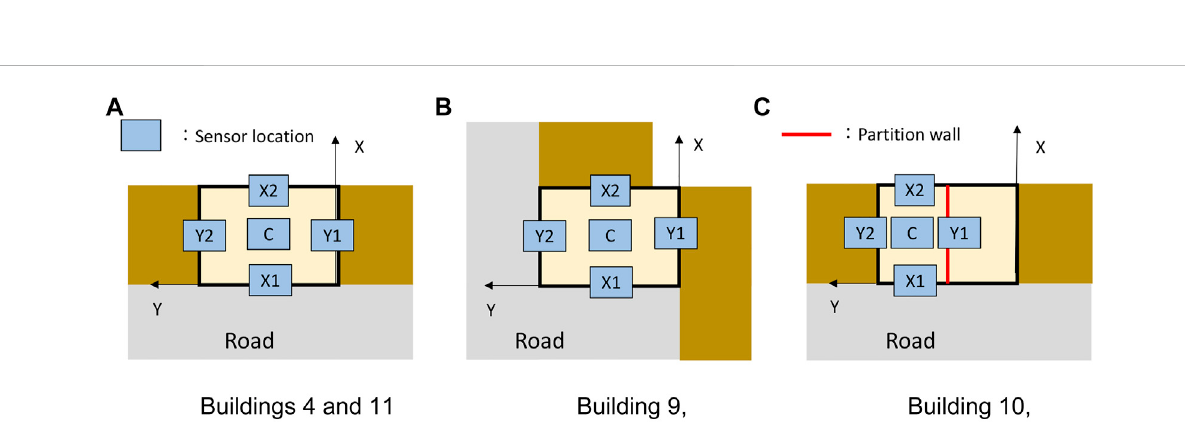
Figure 7. Every measurement was conducted by combining the top fl oor with other fl oor levels of the building. The data sampling period was 200 s under a 100 Hz data sampling interval.